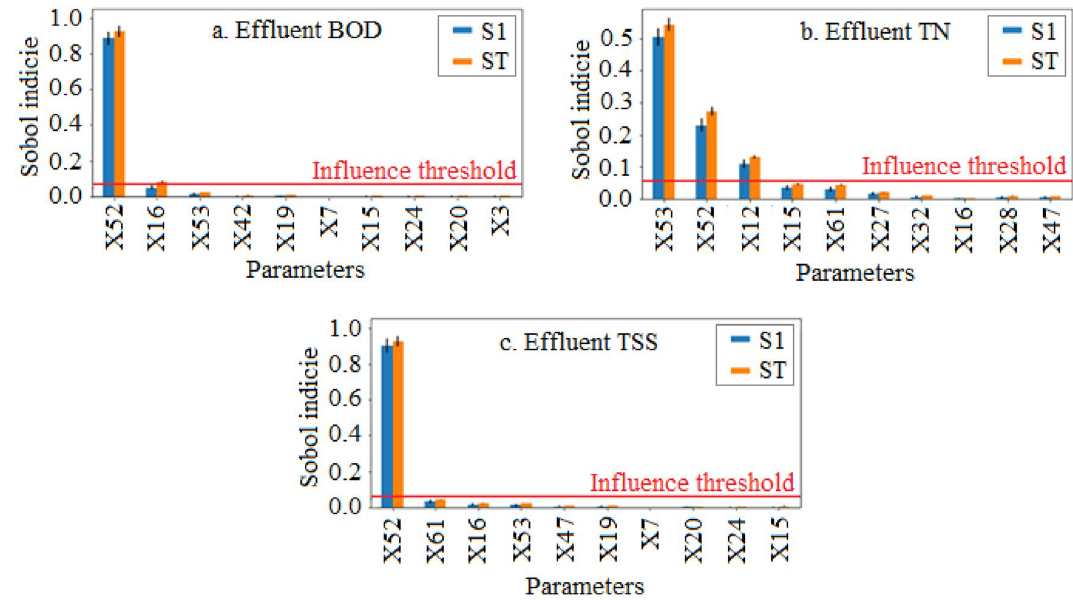
Figure 5. Top 10 parameters ranked according to influence for ( a ) BOD model, ( b ) TN model, ( c ) TSS model with influence threshold displayed